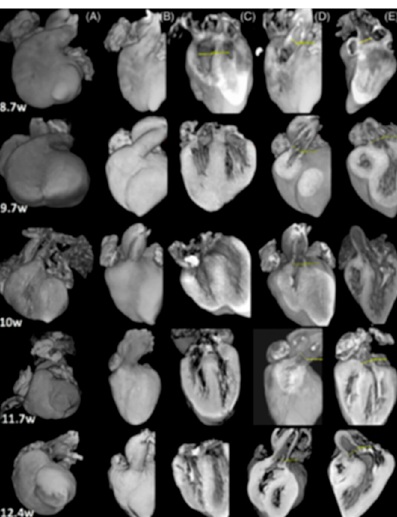
Figure 2. Micro-CT images of different cardiac views (columns) at different gestational ages (rows): ( A ) external apical view; ( B ) external frontal view; ( C ) four-chamber view; ( D ) right outflow view; ( E ) left outflow view [30].